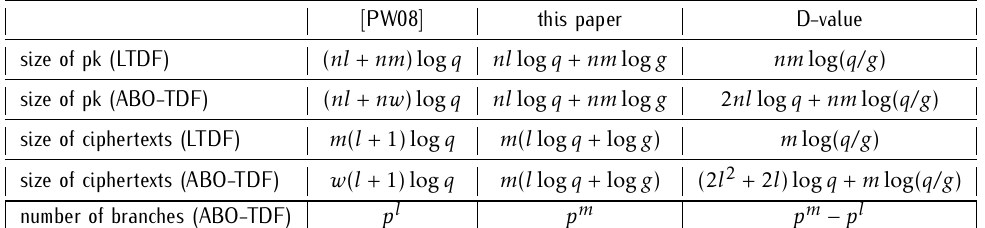
Table 1. <Comparison between LTDF/ABO-TDF in [PW08] and those in this paper.> [PW08] this paper